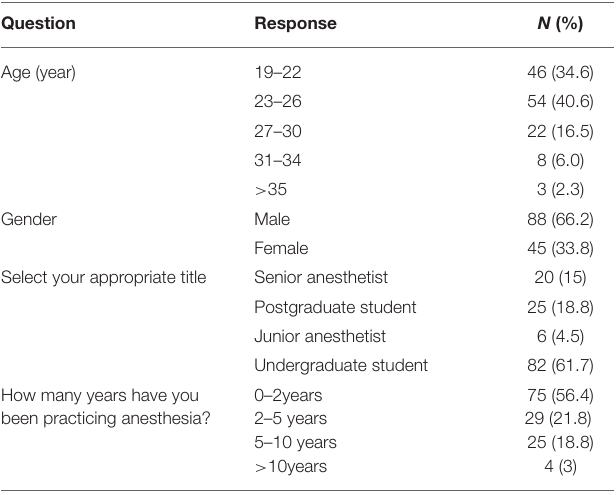
TABLE 1 | Background characteristics of anesthesia provider at the University of Gondar Comprehensive Specialized Hospital (UOGCSH), Gondar, Ethiopia,